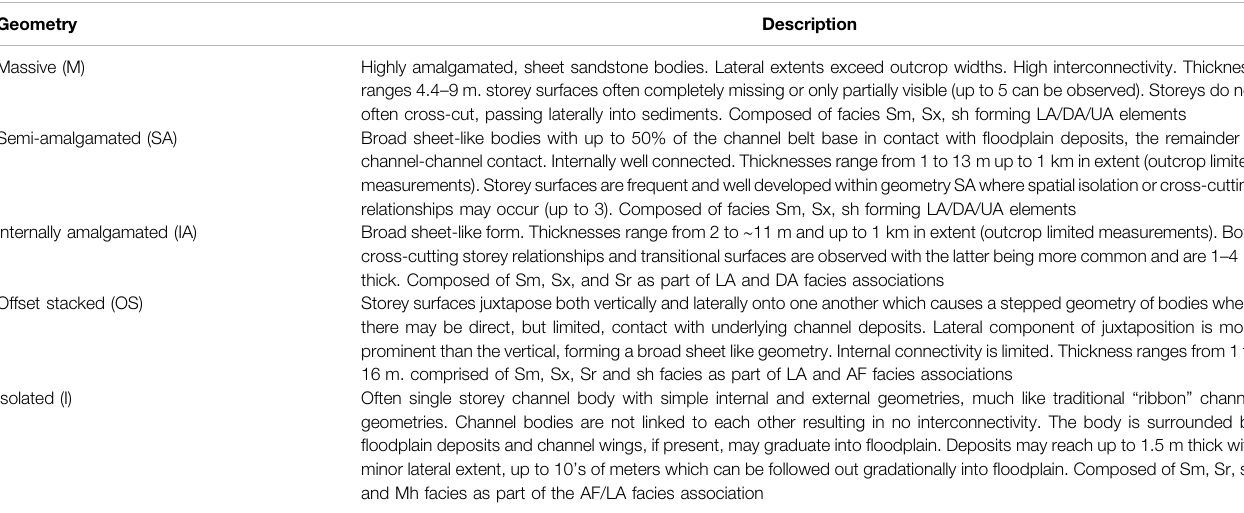
TABLE 3 | Summary descriptions of channel body geometries observed on the Huesca DFS. See Figure 3 for example images. Geometry